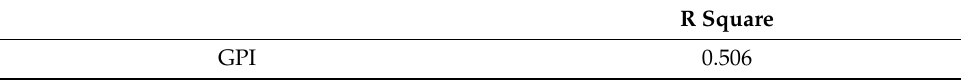
Table 7. R 2 and Adjusted R 2